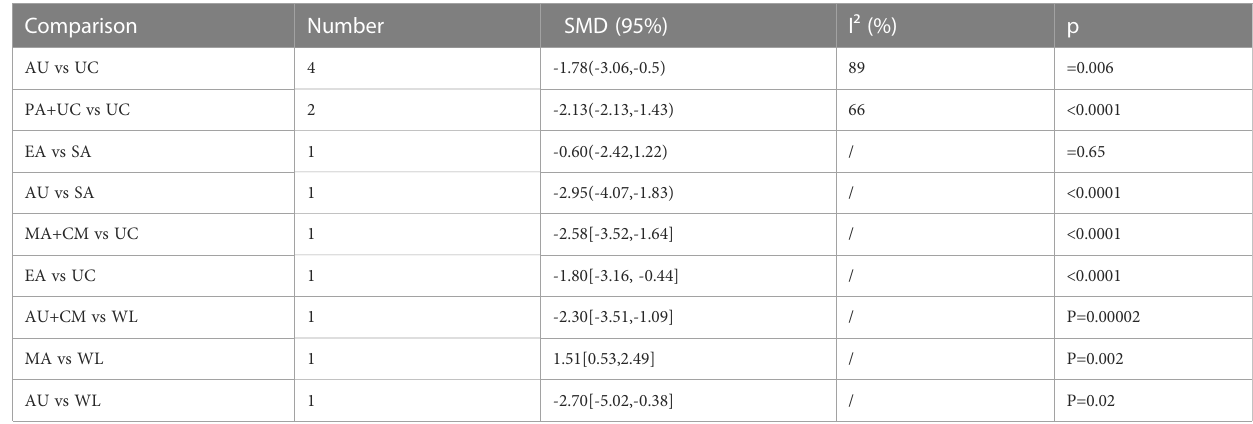
TABLE 3 Pairwise meta-analysis of PSQI.